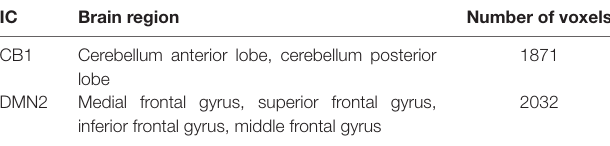
TABLE 3 | Spatial distributions of important independent components (ICs).